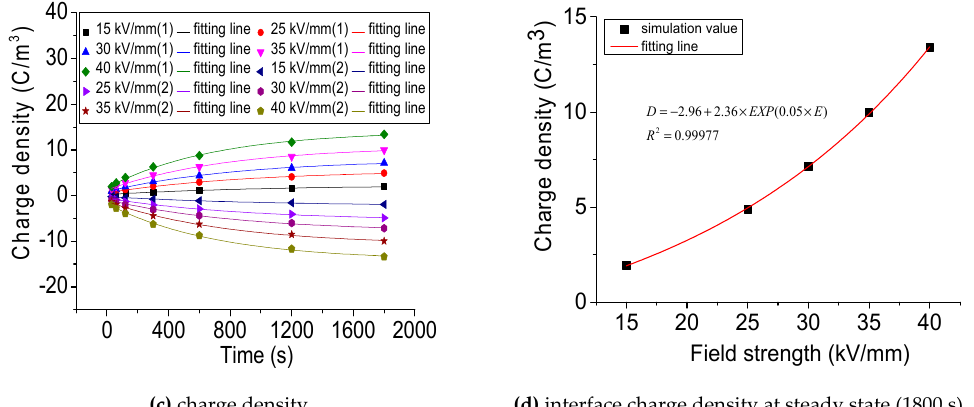
Figure 4. Space/interface charge simulation for three-layer “OIP + OG + OIP” under different electrical field strengths (20 °C).